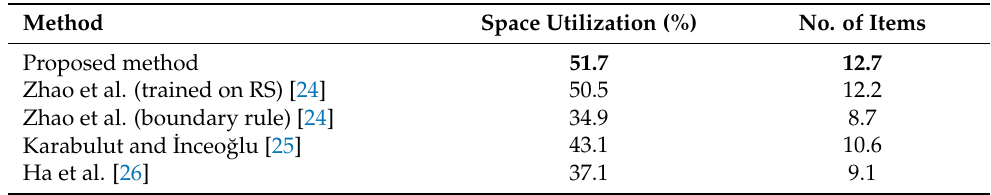
Table 5. The packing results of different methods on the Zhao et al. [24] dataset. Method Space Utilization (%) No. of Items Proposed